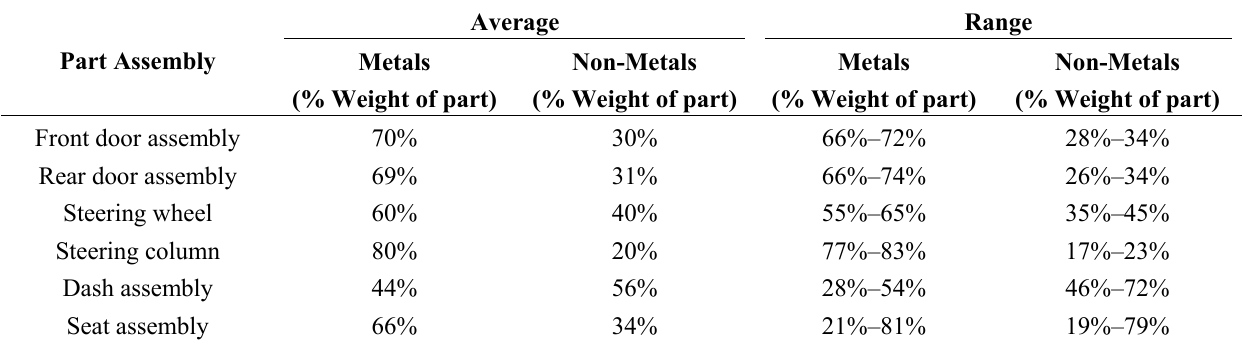
Table 1. Examples of parts assemblies having significant non-metallic materials content